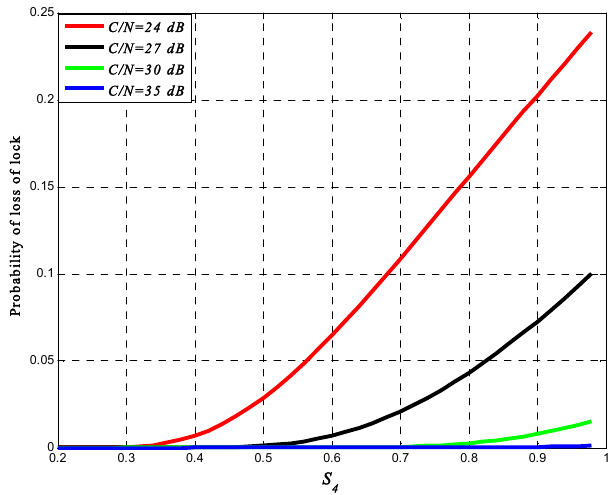
Figure 10. Probability of loss of lock.